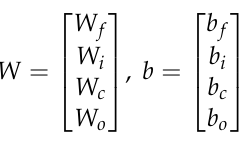
The forget gate calculates the information to forget in the cell and applies the current input ( 𝑥 (cid:3047) ) from the current time step and the previous hidden state ℎ (cid:3047)(cid:2879)(cid:2869) from the previ- ous time step to the sigmoid function to calculate the value between 0 and 1. 𝑓 (cid:3047) = 𝜎(cid:3435)𝑊 (cid:3033) ⋅ (cid:4670)𝑥 (cid:3047) , ℎ (cid:3047)(cid:2879)(cid:2869) (cid:4671) + 𝑏 (cid:3033) (cid:3439)